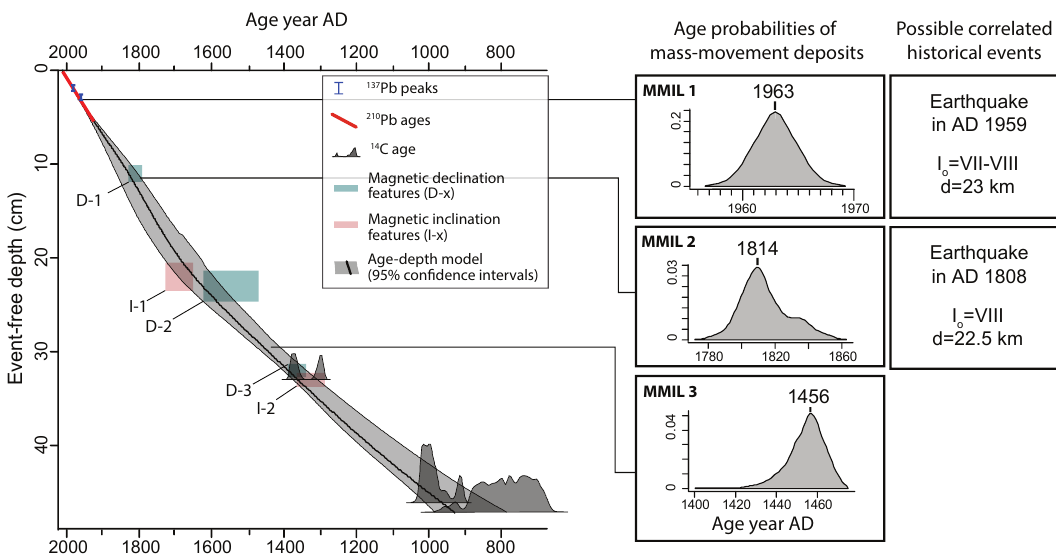
Figure 6. Age–depth model for core FOR13P2 calculated using the “clam” R-code package, combining historic 137 Cs peaks, 210 Pb ages, calibrated 14 C ages and magnetic features on the left side. Probability distribution frequencies of mass-movement ages and possible correla- tions to historical earthquakes on the right